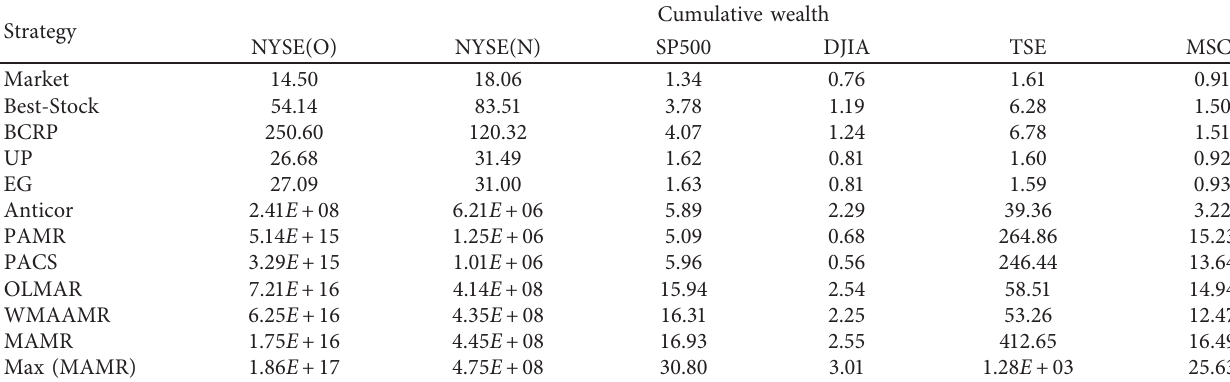
Table 3: Cumulative wealth achieved by various strategies on the six datasets.